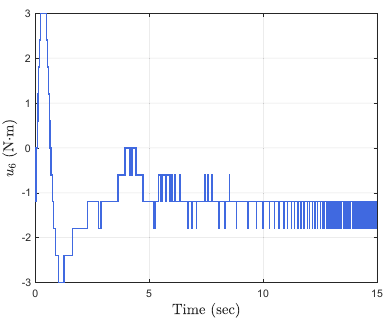
Figure 10. Event − triggered control input u 6 .